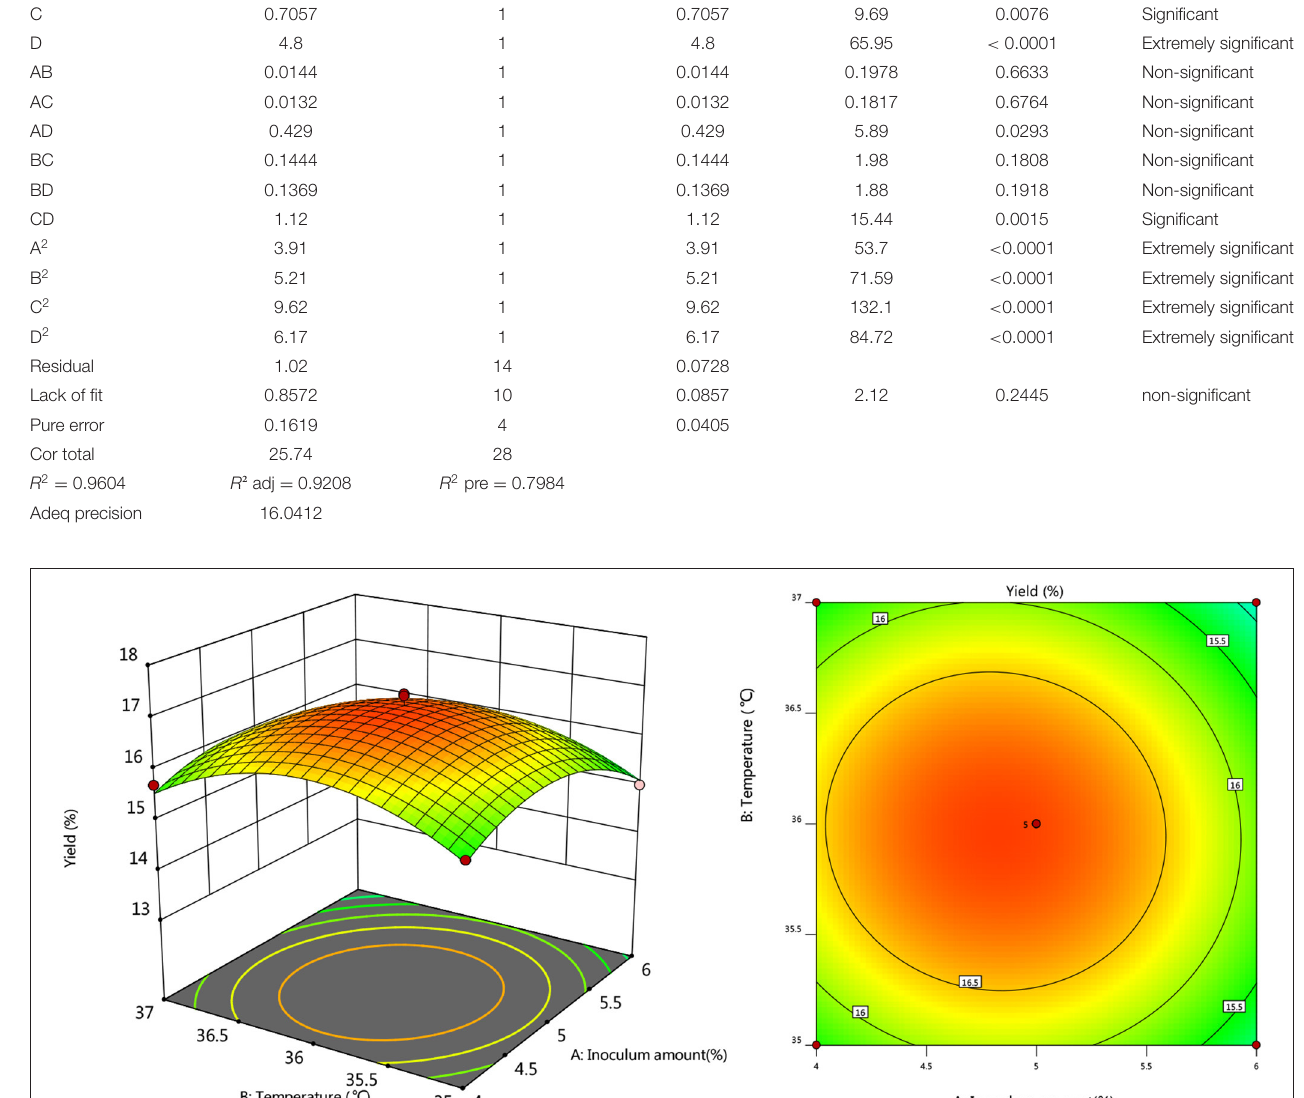
extracted by the traditional hot water method. Compared with the traditional hot water method, the fermentation method takes a long time, but requires low temperature and low energy consumption. It is mainly destroyed by extracellular enzymes produced by the fermentation of Aspergillus niger . Artemisia annua cells promote polysaccharide release.